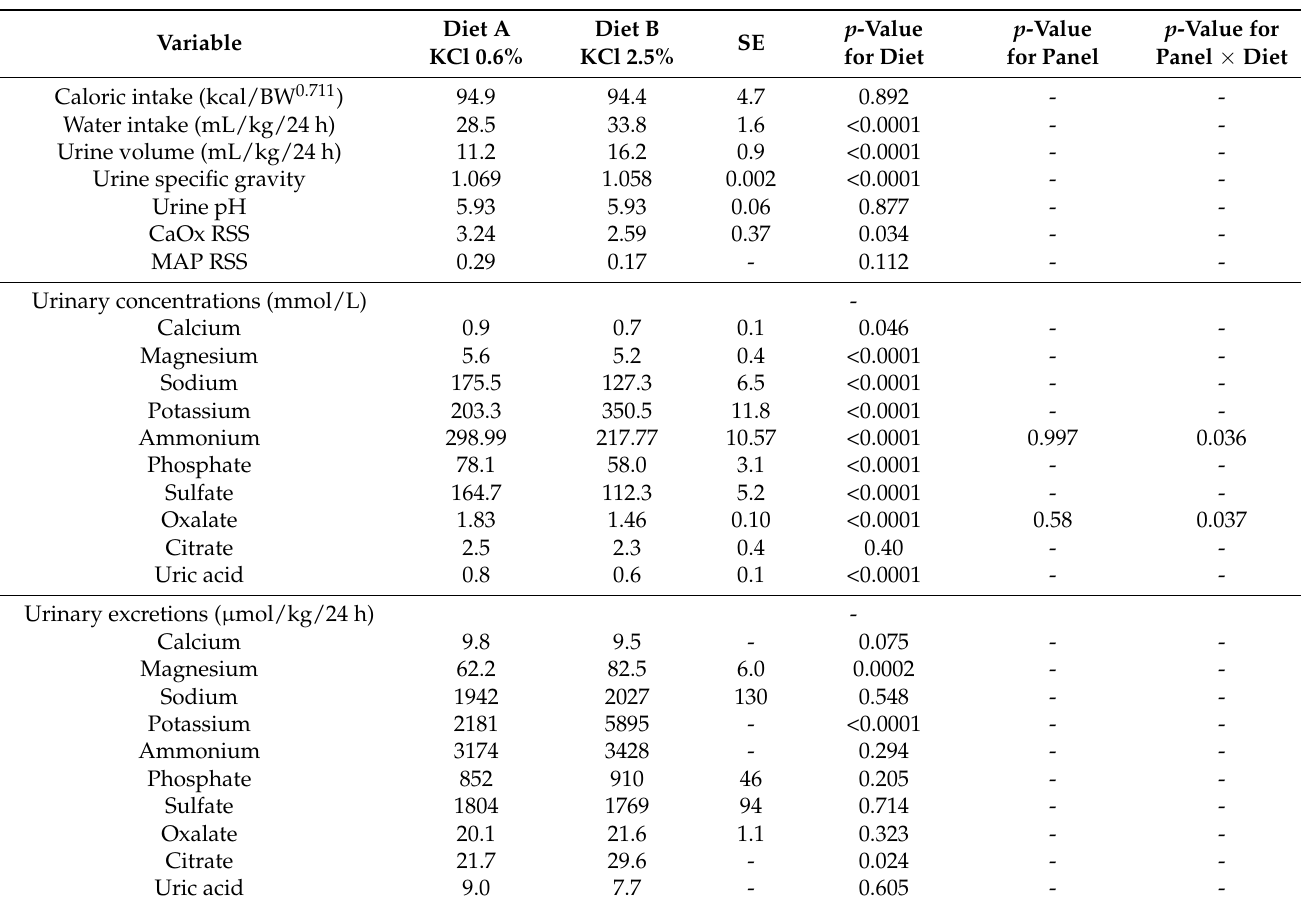
Table 2. Diet and water intakes, and urine variables in cats ( n = 17) fed the two diets differing in potassium chloride